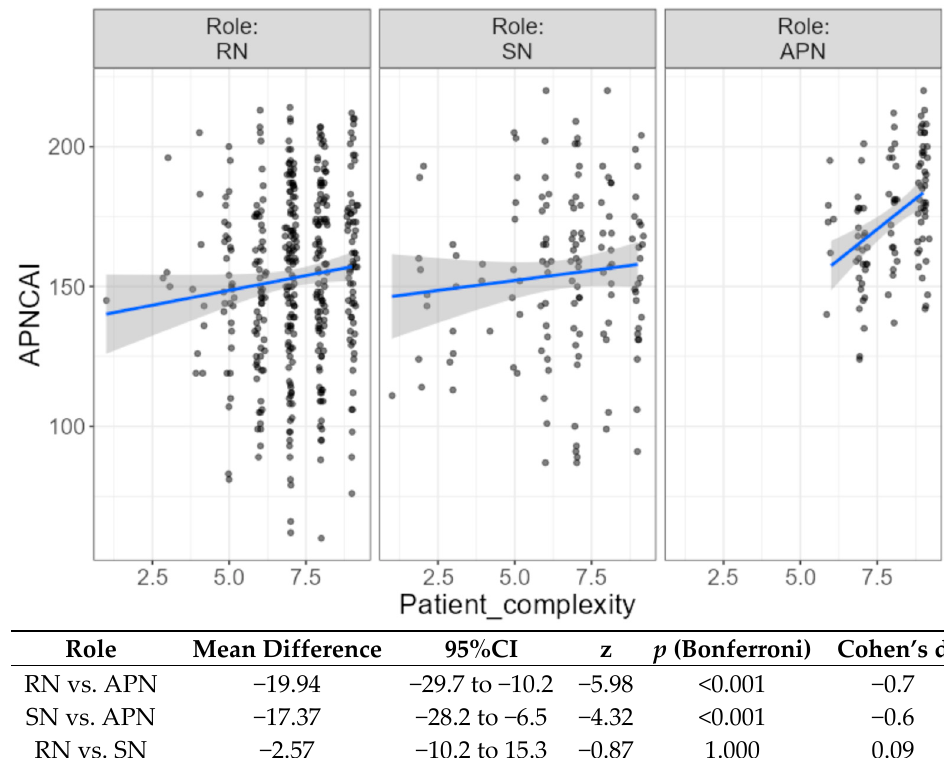
Figure 3. Advanced competencies among different nursing roles and complexity of patients attended by nurses.